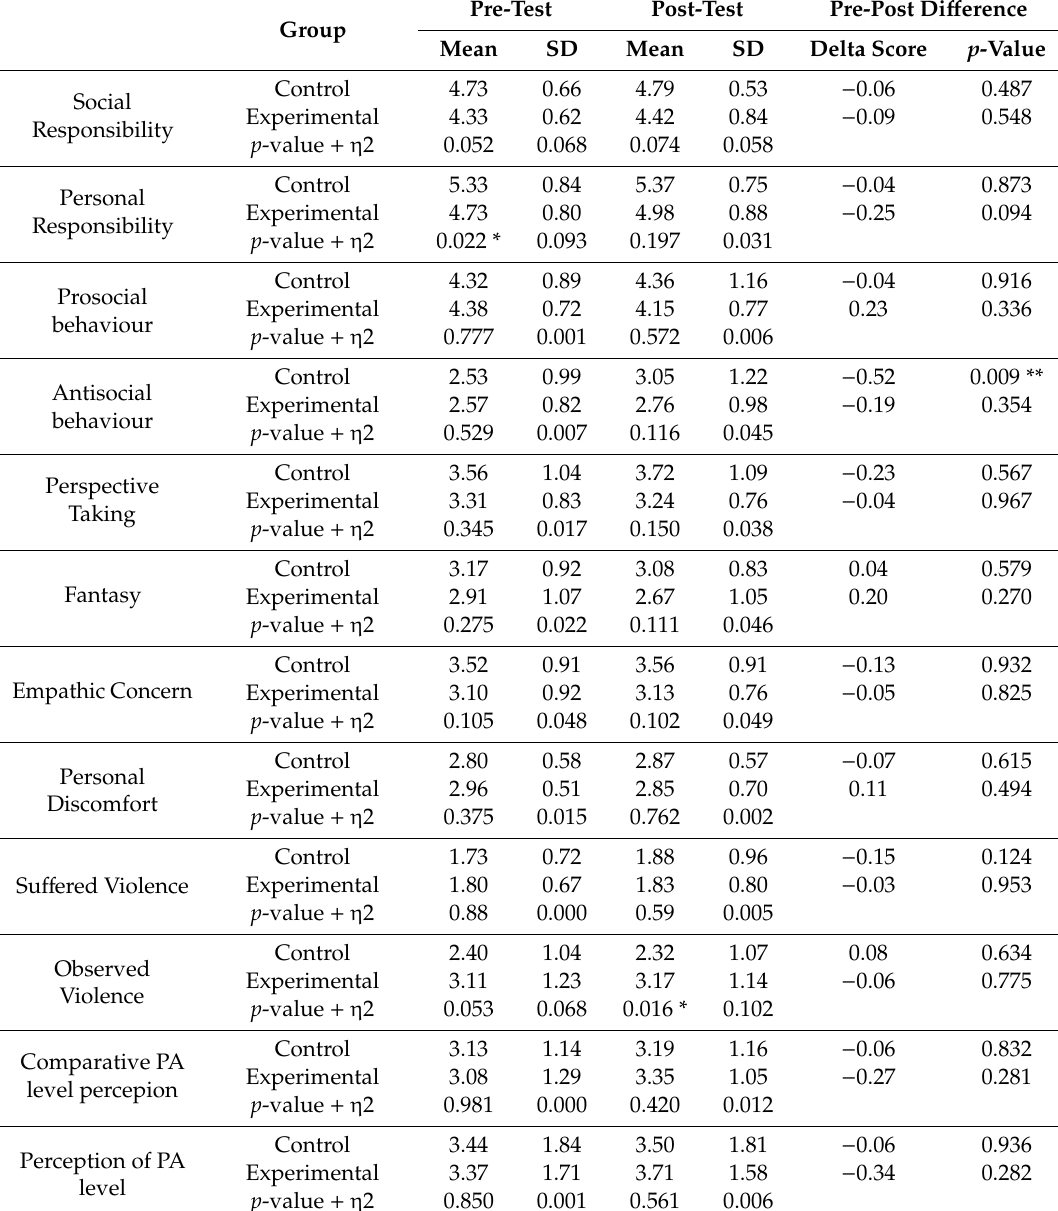
Table 2. Analysis of intervention results